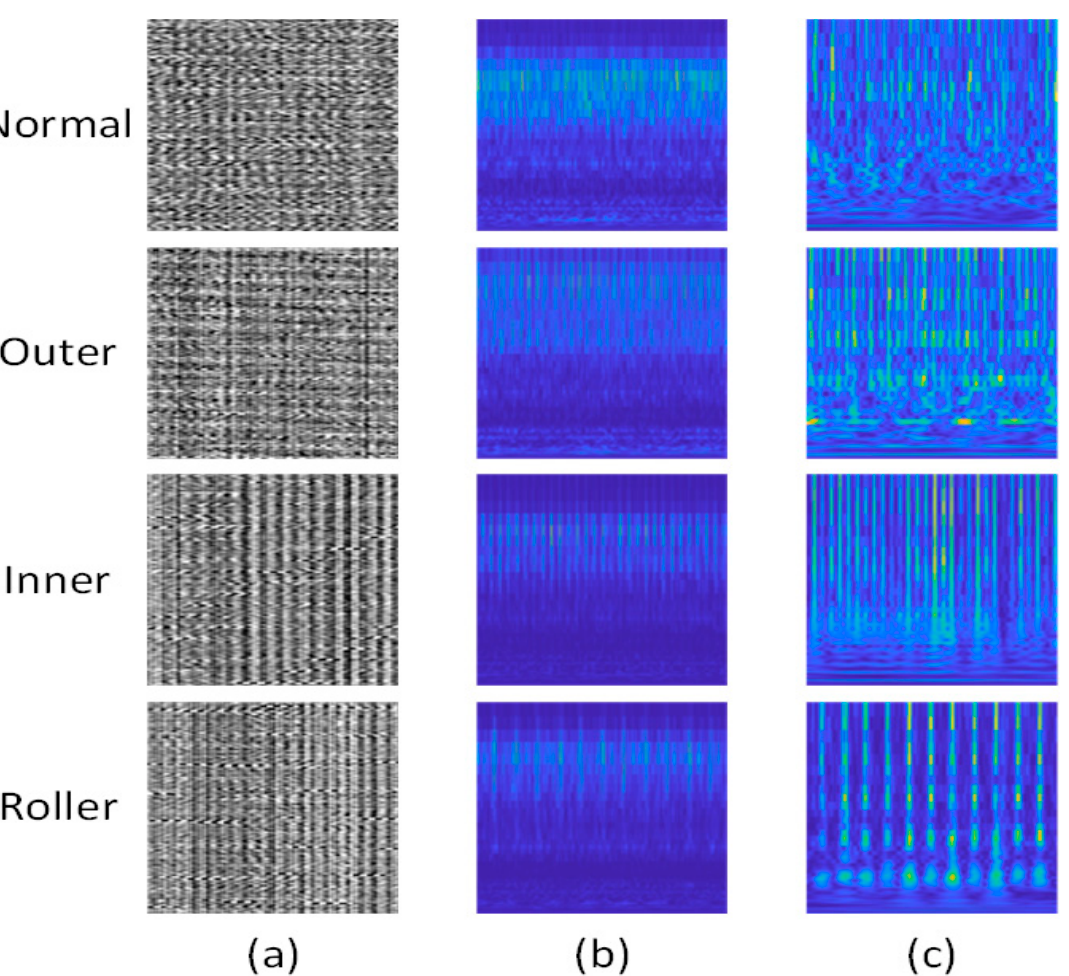
Figure 6. The generated image of bearing fault signal from different methods: ( a ) Vibration image ( b ) Conventional Wavelet spectrogram image ( c ) DSWI.